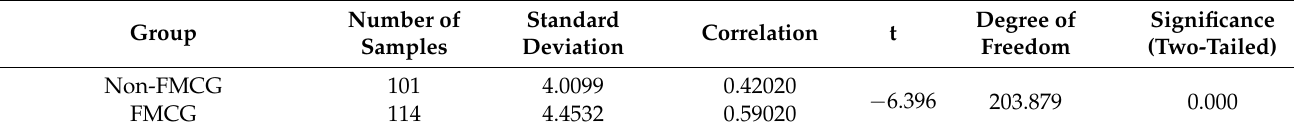
Table 12. The impact of different promotional product types in quantity-limited promotions on downward anticipated regret.